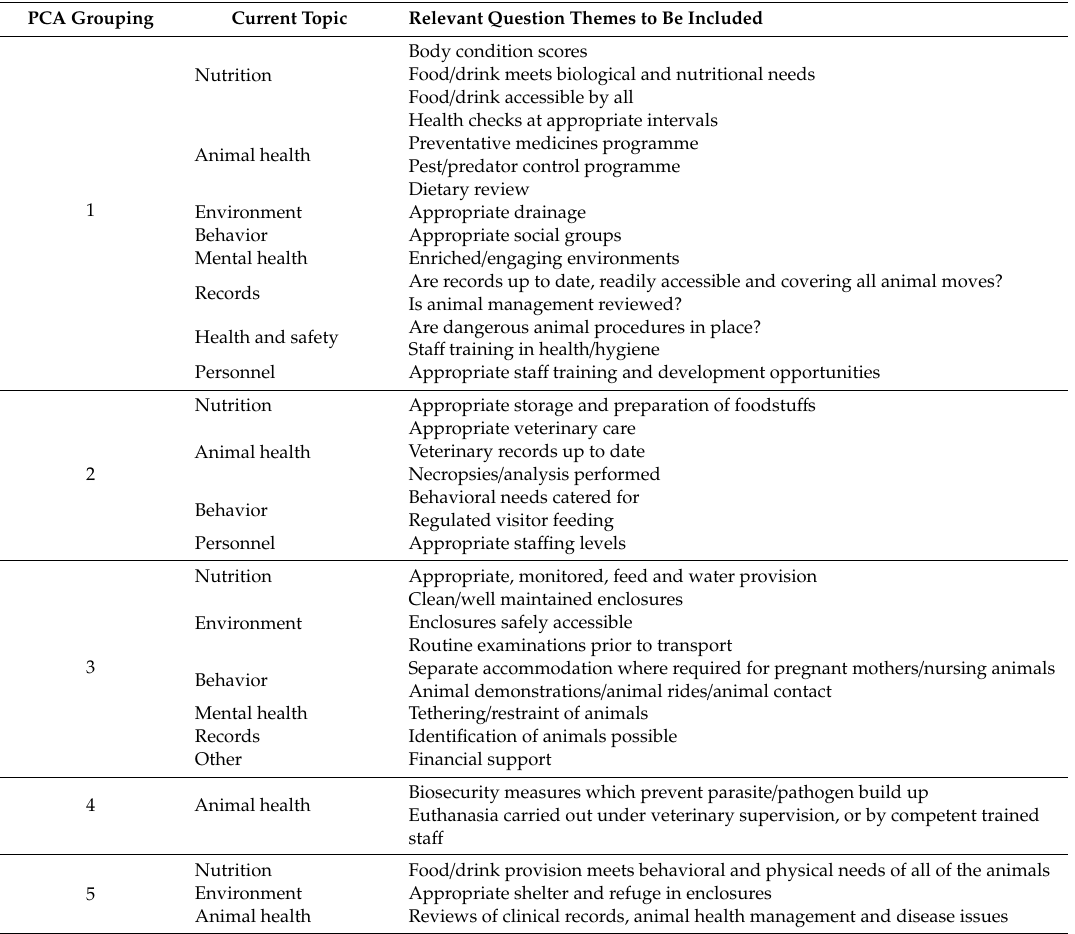
Table 2. Summary of recommended questions to be included in future assessments of zoo animal welfare in developing country